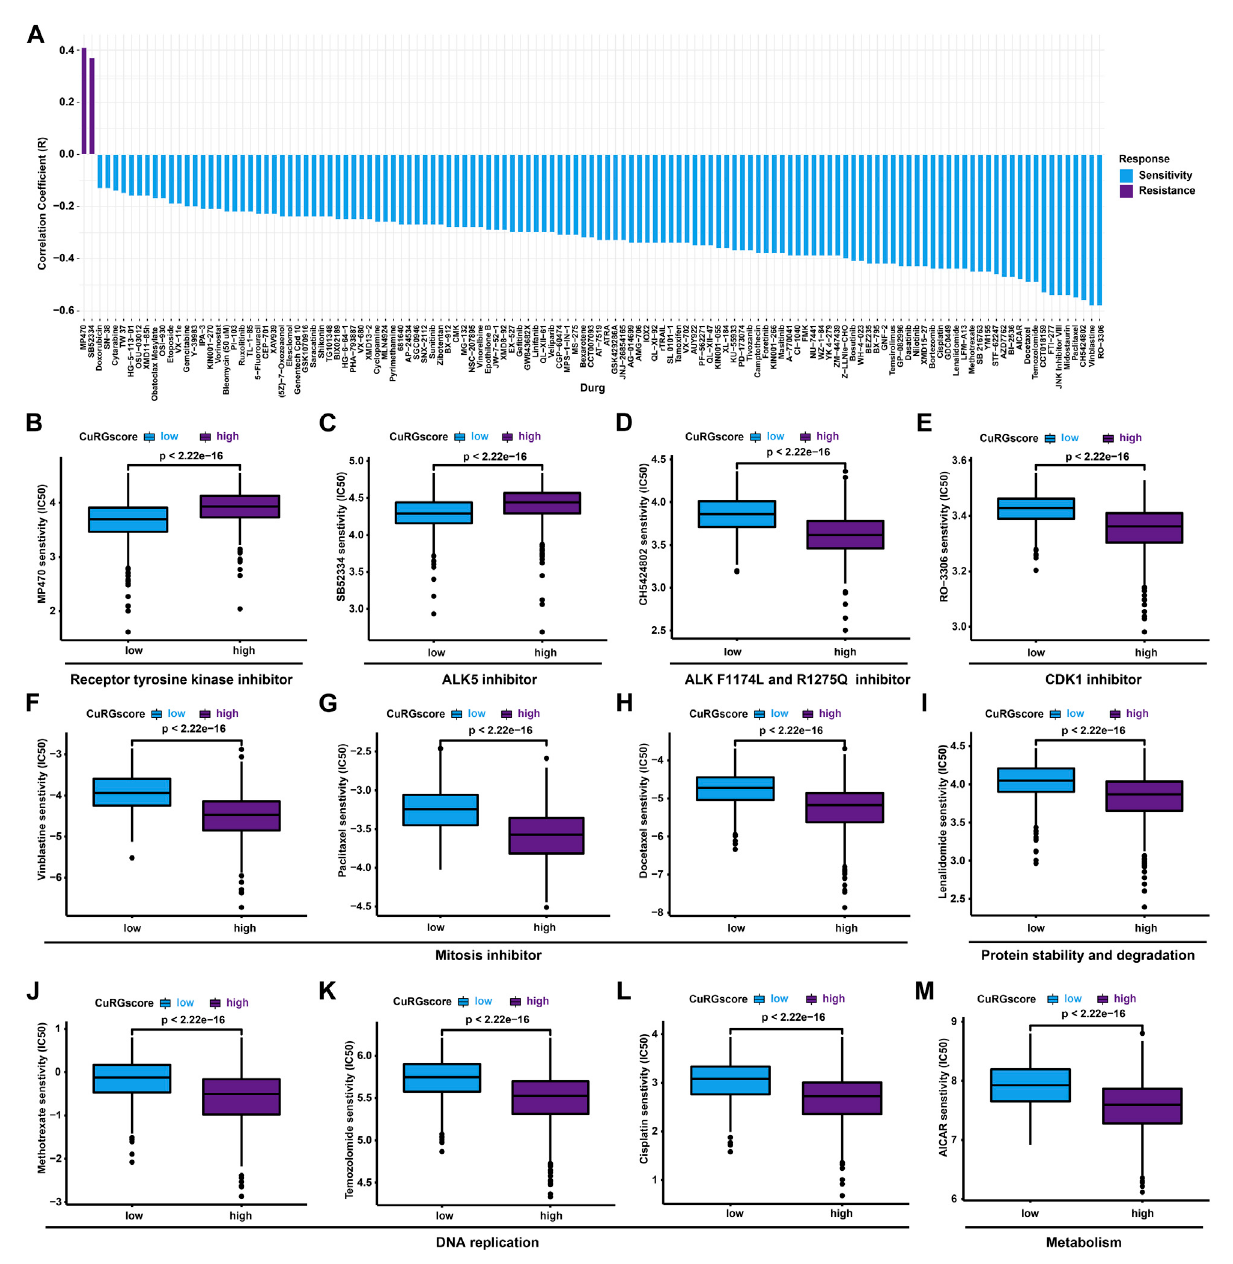
FIGURE 8 Chemotherapeutic responses in high- and low-CuRGscore patients with LUAD. (A) Common drug sensitivity and resistance for high- and low-risk patients withLUADusingpRRopheticanalysisinthetraining and external validation cohorts. (B, C) Drugresistancefor receptortyrosine kinasesinhibitor, MP470 (B) , and ALK5 inhibitor, SB52334 (C) in high-risk patients with LUAD. (D, E) Drug sensitivity for ALK F1174L and ALK R1275Q inhibitor, CH5424802 (D) ,andCDK1inhibitor,RO-3306 (E) ,inhigh-riskpatientswithLUAD. (F – H) Chemotherapeuticsensitivityformitosisinhibitors,suchas vinblastine (F) , paclitaxel (G) and docetaxel (H) in high-risk patients with LUAD. (I) Chemotherapeutic sensitivity for protein stability and degradation (lenalidomide) in high-risk patients with LUAD. (J – L) Chemotherapeutic sensitivity for DNA replication, including vinblastine (J) , paclitaxel (K) , and Cisplatin (L) in high-risk patients with LUAD. (M) Drug sensitivity for metabolism regulator, AICAR, in high-risk patients with